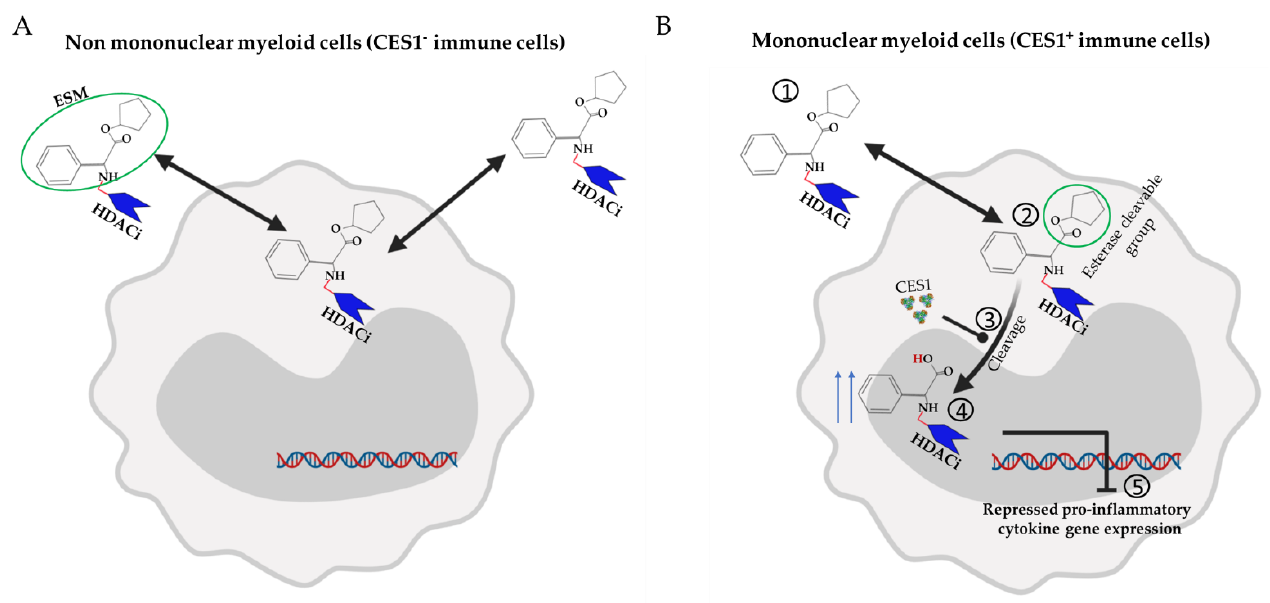
Figure 3. Selective targeting of myeloid cells with HDACi. CES-1 expression in humans is restricted to hepatocytes and cells of the mononuclear myeloid lineage, such as monocytes and macrophages. ( A ) When ESM-HDACi enters into CES-1-negative cells such as T and B cells, the compound freely diffuses out of the cells; lack of retention of the HDACi minimizes the pharmacological effect. ( B ) After entry of ESM-HDACi into CES-1-positive cells (1), esters are selectively hydrolyzed by the CES-1 enzyme (2), generating charged acids (3) that are less able to cross the membrane. This leads to intracellular retention of HDACi (4) and enhanced pharmacological effect (e.g., histone hyperacetylation and repression of proinflammatory genes) (5).